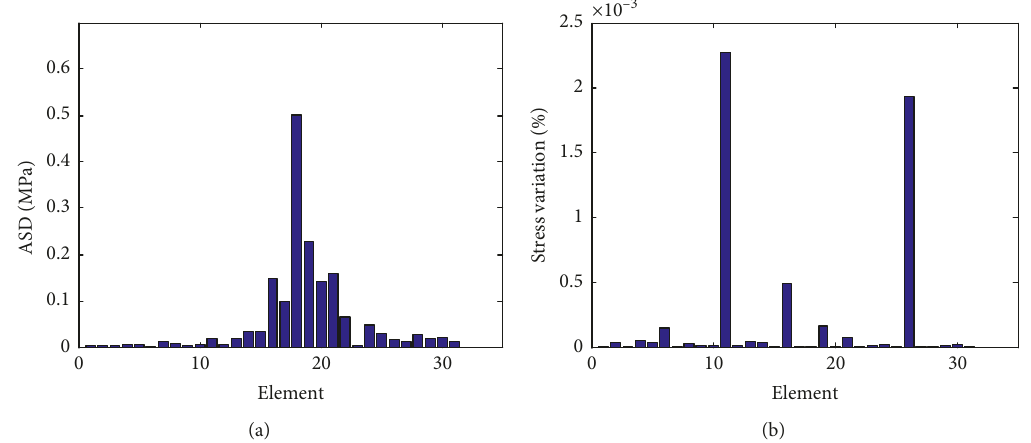
Figure 11: A single damage at element 18 using 3% noise displacements and local-based approach of (a) ASD and (b) stress variation rate.